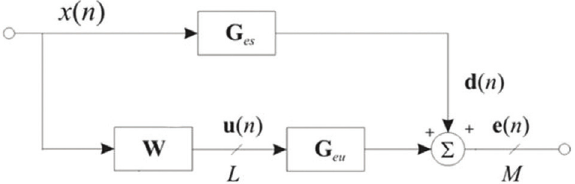
Fig. 3. Block diagram of feedforward control problem with L actuators and M